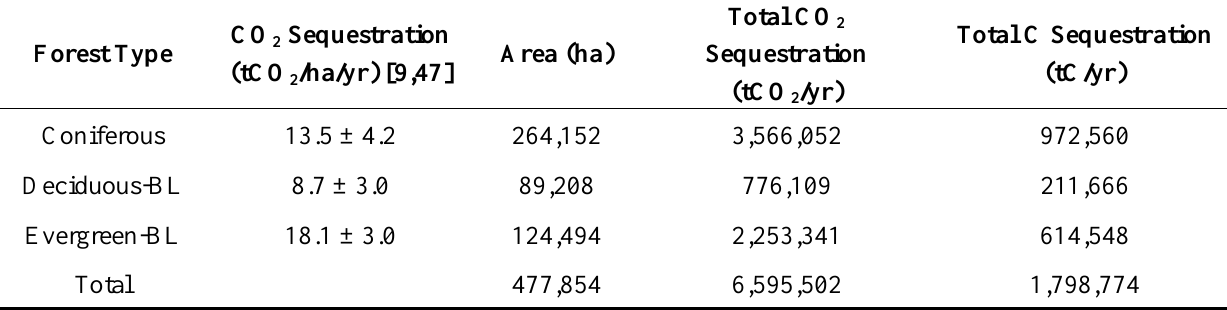
Table 5. CO sequestration by forest types in Oita Prefecture using the IPCC 2